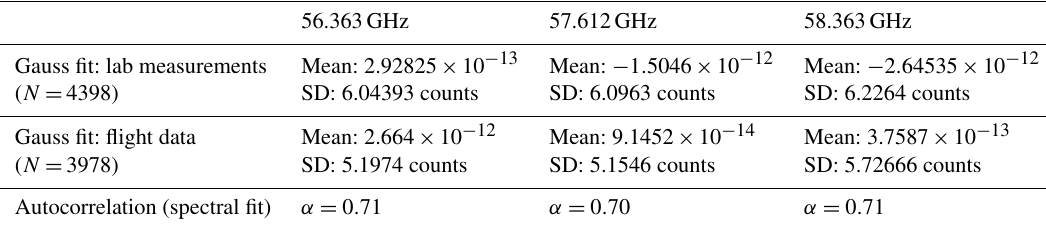
Figure 6. Measured signal (grey line) at 56.363GHz while looking at the ambient target inside the cold chamber as well as a running average (light, blue line), mean value (blue line), and linear fit (black line). The corresponding brightness temperature change in the linear fit during the segment is about 0.8K. Table 2. HALO MTP instrument noise characteristics at each of the three standard frequency